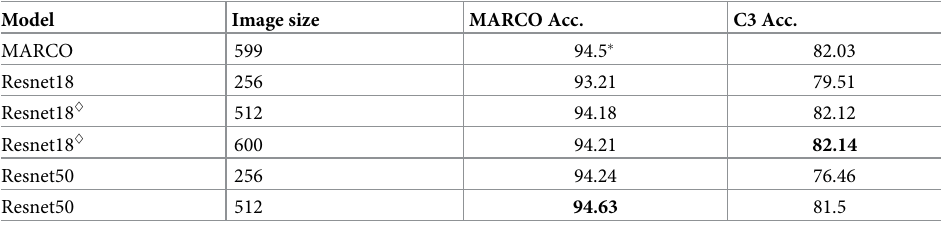
Table 2. Performance of different ResNet models on the MARCO and C3 test datasets.